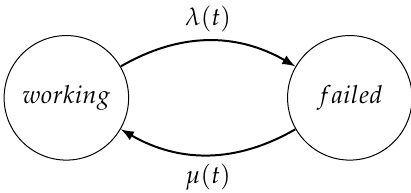
Figure 2. Two state model from the availability point of